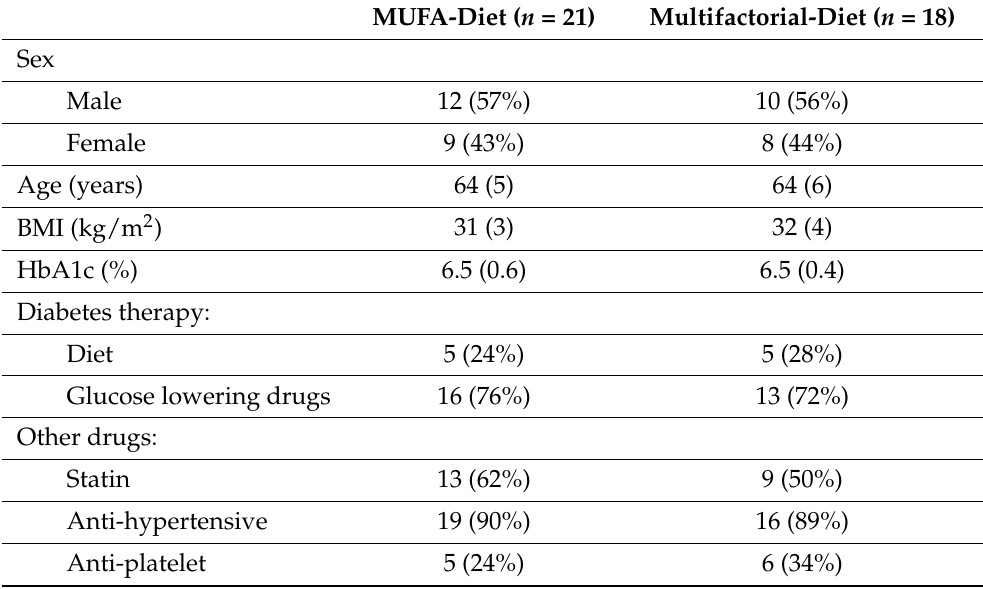
Table 1. Baseline characteristics of the participants. Data are n (%) or mean (Standard Devia- tion). Not statistical differences between the two groups. Abbreviations: BMI = body mass index; HbA1c = glycated